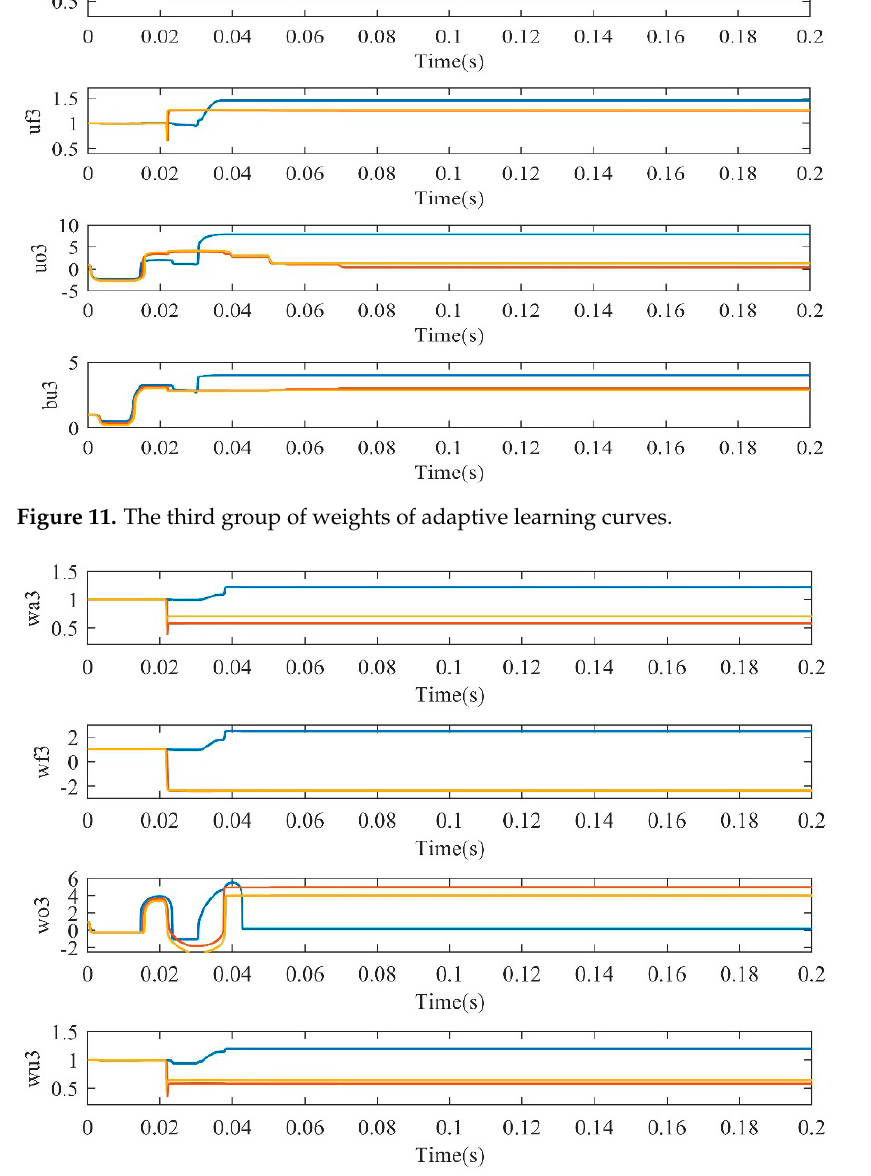
Figure 12. The fourth group of weights of adaptive learning curves.